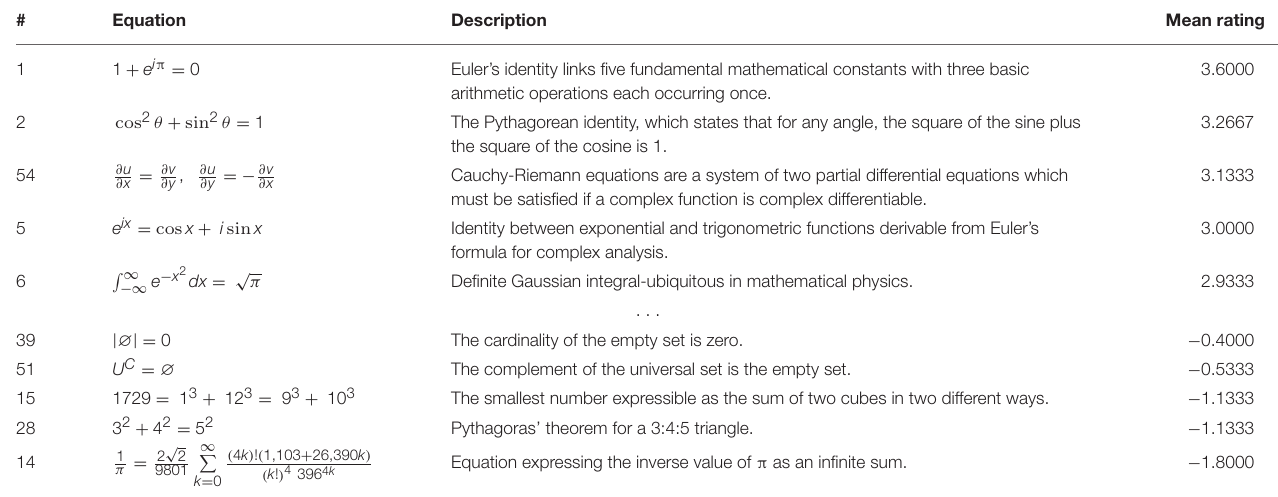
5 to 5) are shown in the upper section while those given the lowest ratings are shown − +